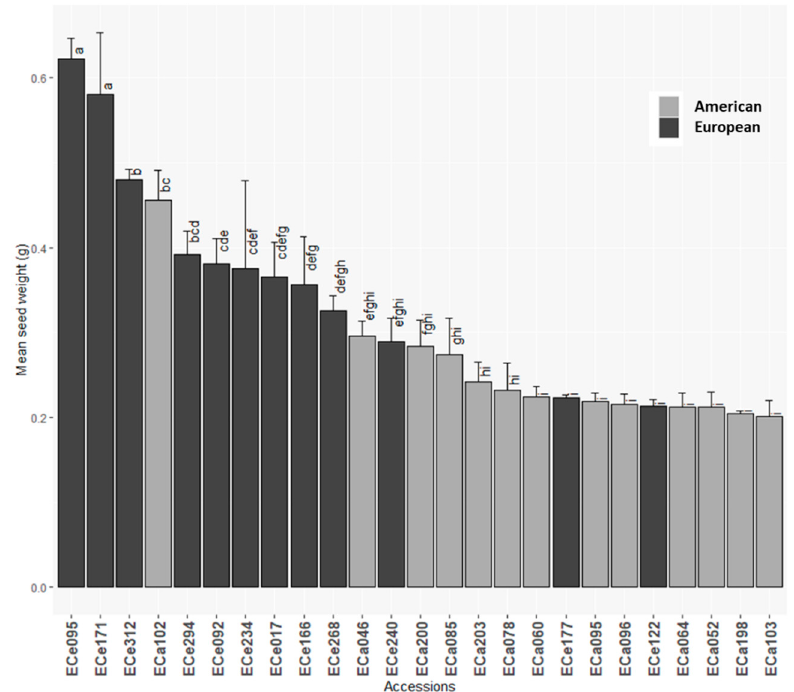
Figure 2. Mean seed weights for the 25 American and European accessions. Columns with different letters are significantly different ( p < 0.05; Tukey test).